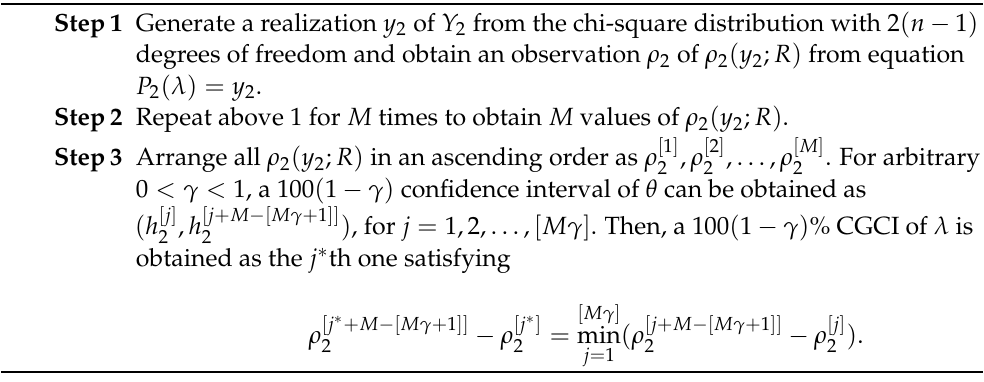
Algorithm 4: CGCI for parameter λ